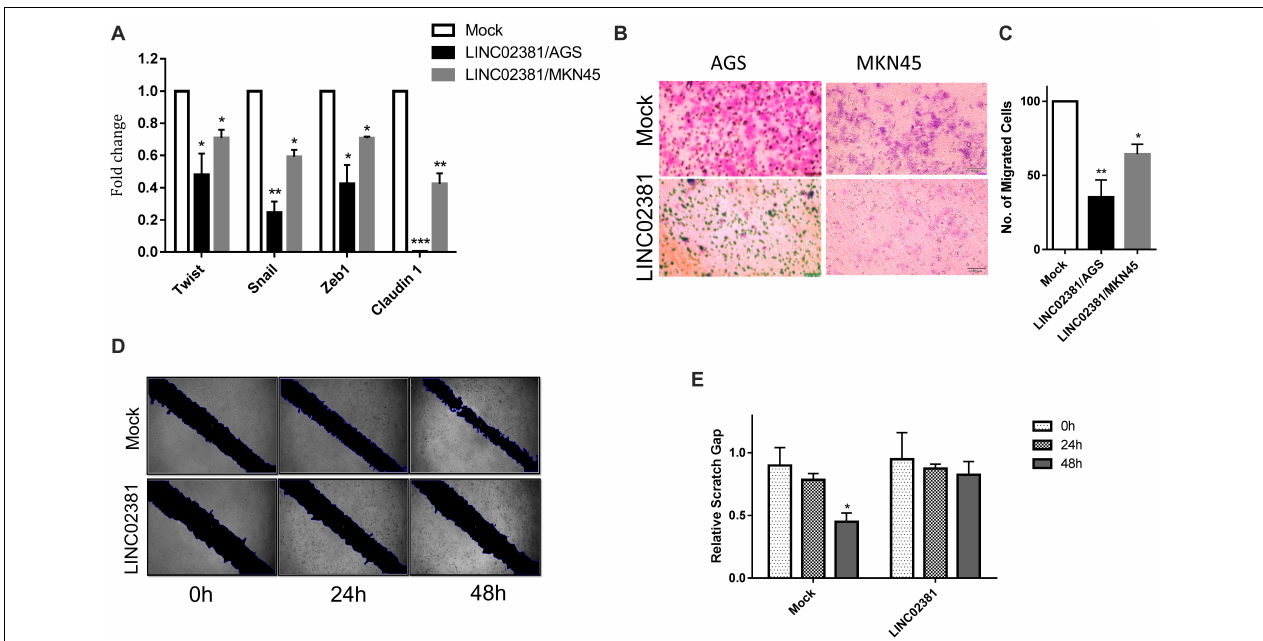
FIGURE 6 | LINC02381 overexpression effect on the EMT phenotype. (A) RT-qPCR analysis of EMT markers expression in AGS and MKN45 cells transfected with LINC02381 expressing vector, compared with control transfected cells. The expression level of all of EMT markers has been reduced following the LINC02381 overexpression, in both cell lines. Data represent the mean ± SEM from three independent experiments. * P < 0.05, ** P < 0.01, *** P < 0.001. (B,C) Shows Transwell assay administrated 24 h after LINC02381 or control vector transfection. Bar plot analysis of the migrated cells indicated reduced rate of migration, following the LINC02381 overexpression in both cell lines. Data are shown as mean ± SEM. ** P < 0.01. (D,E) In vitro wound healing analysis of AGS cells transfected with LINC02381 expressing or control vectors. Results indicate that LINC02381 overexpression reduces migration capability of the cells.